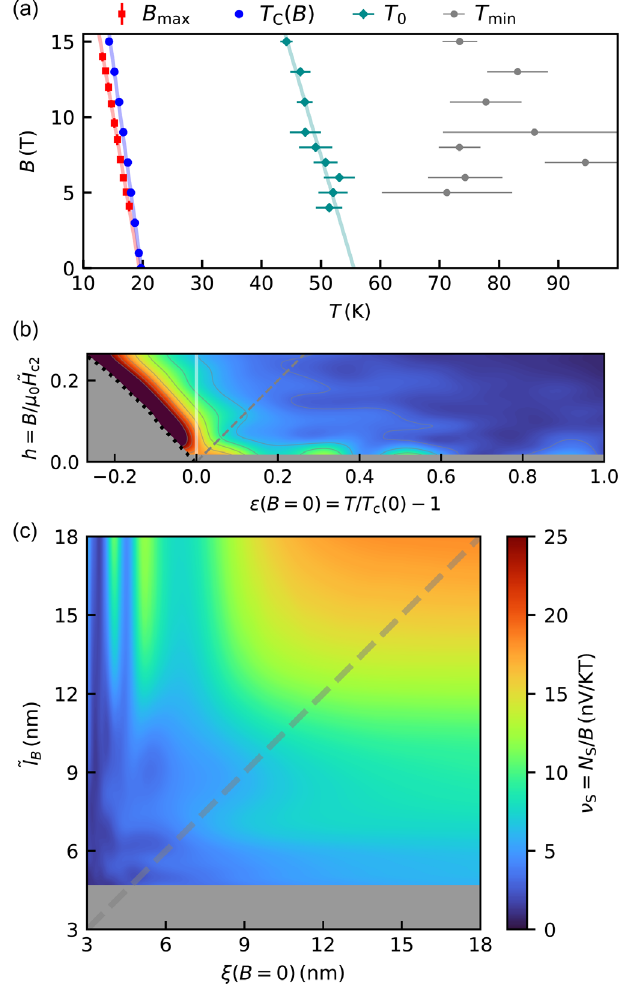
FIG. 4. Superconducting Nernst effect vs temperature and B field. (a) Characteristic quantities extracted from the Nernst signal: B denotes the fitted peak of N ð B Þ [see Fig. 2(b)]; max T T are the zero crossing and minimum of N , 0 and min respectively; T c denotes the resistive superconducting transition temperature. All lines are linear fits. Error bars indicate fit uncertainties. (b) Quasiparticle subtracted contribution to the Nernst coefficient ν S as a function of dimensionless distance to the critical temperature ϵ and dimensionless field h . The black dotted line shows T c ð B Þ ; the gray dashed line is h ¼ ϵ . (c) ν S as a ˜ l function of correlation length ξ and magnetic length B . The ˜ l ¼ ξ dashed line shows B